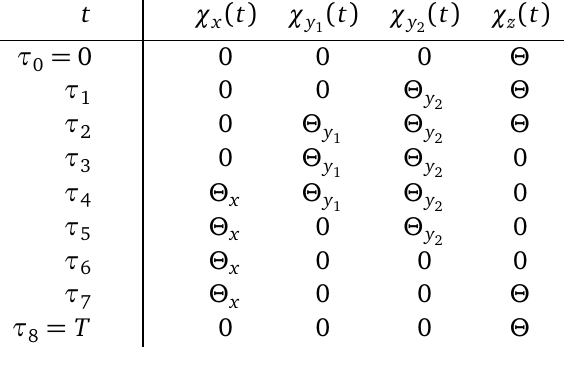
( t ) at the key configurations t = τ i